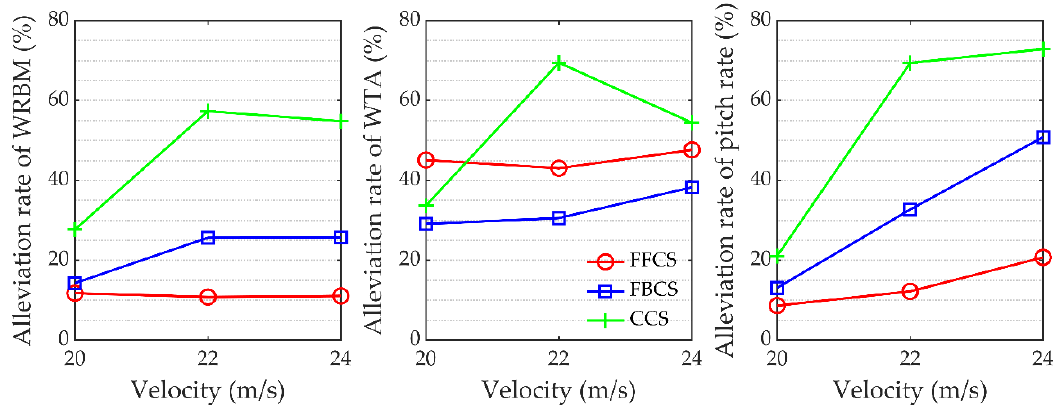
Figure 24. Gust alleviation rates of three control systems (gust frequency is 2.5 Hz).